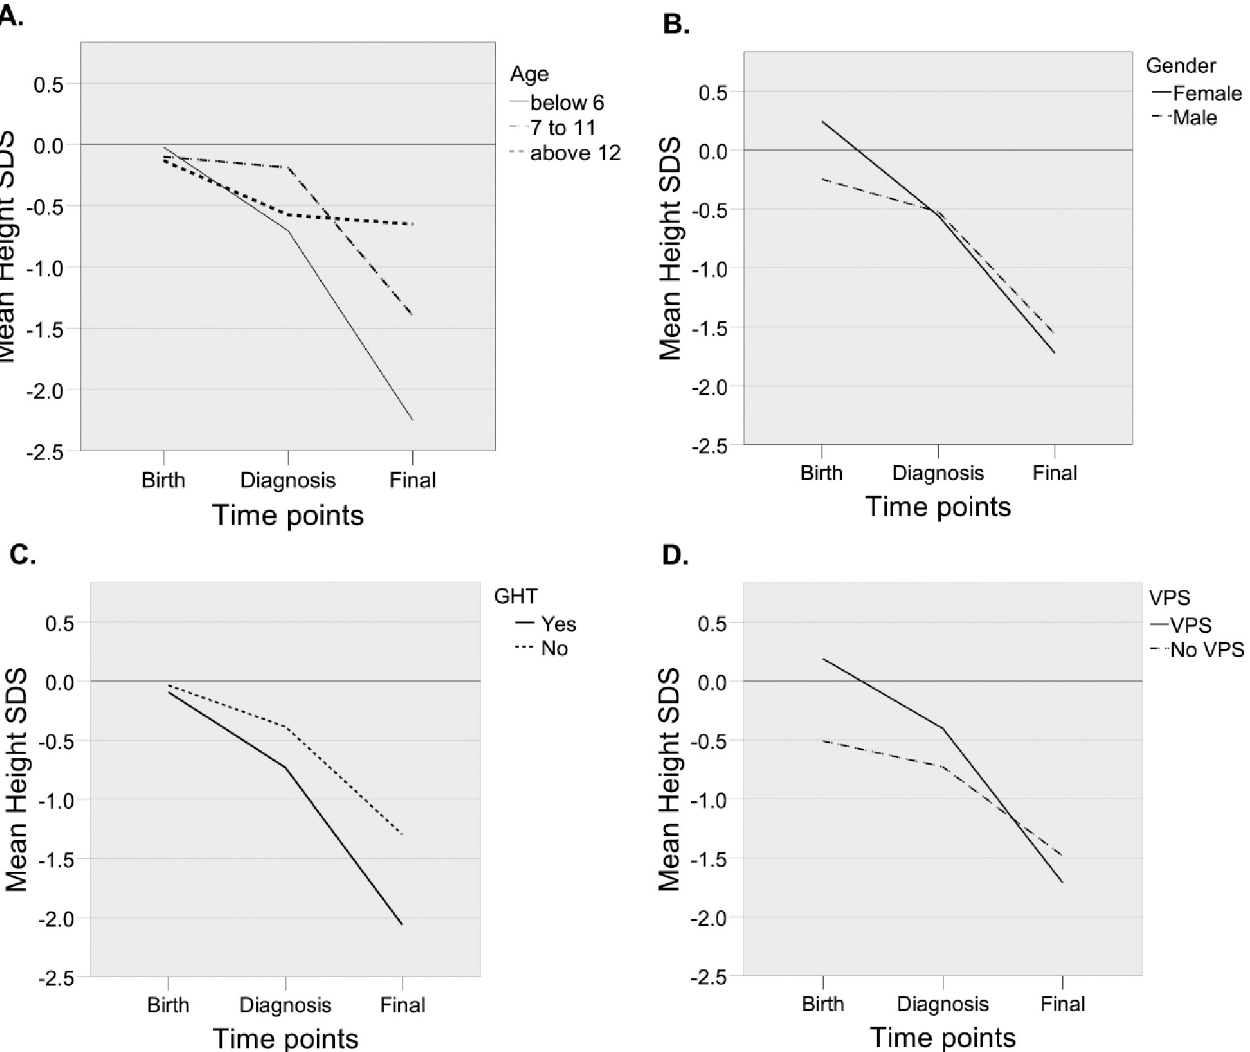
Fig 2. Mean length/height SDS at birth, diagnosis, and follow-up. By age (A), patient gender (B), and growth hormone replacement therapy (GHT) at any time (C) or ventriculoperitoneal shunt (VPS) (D).